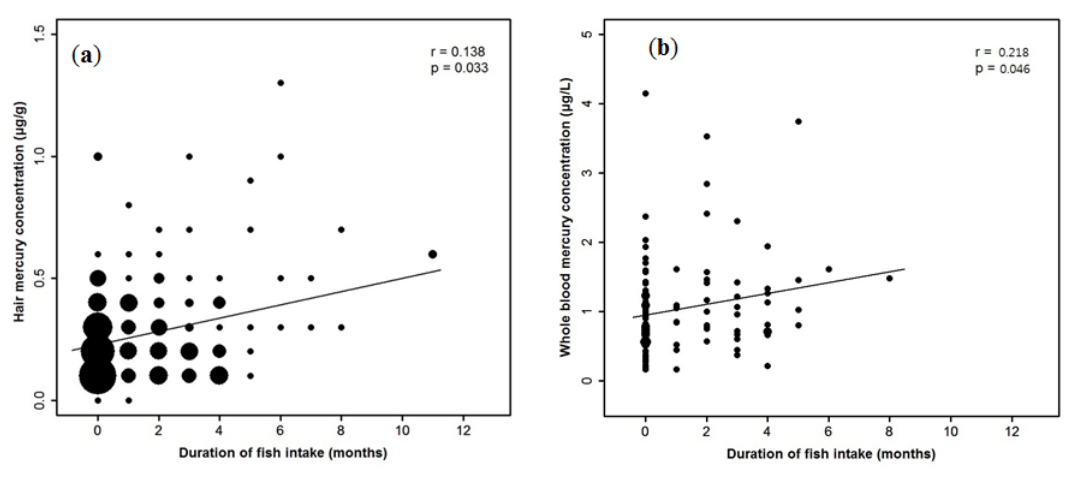
Figure S3. Correlation between duration of fish intake and mercury content in hair ( a ) and in whole blood ( b ).